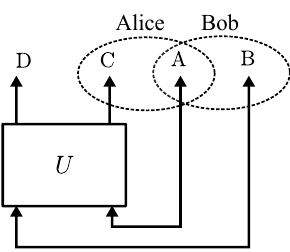
Figure 6 . The AMPS puzzle from the perspective of the monogamy of entanglement. Alice can distill an EPR pair by accessing AC while Bob can distill an EPR pair by accessing AB . Note that A can be any subsystem of the early radiation R as long as of U